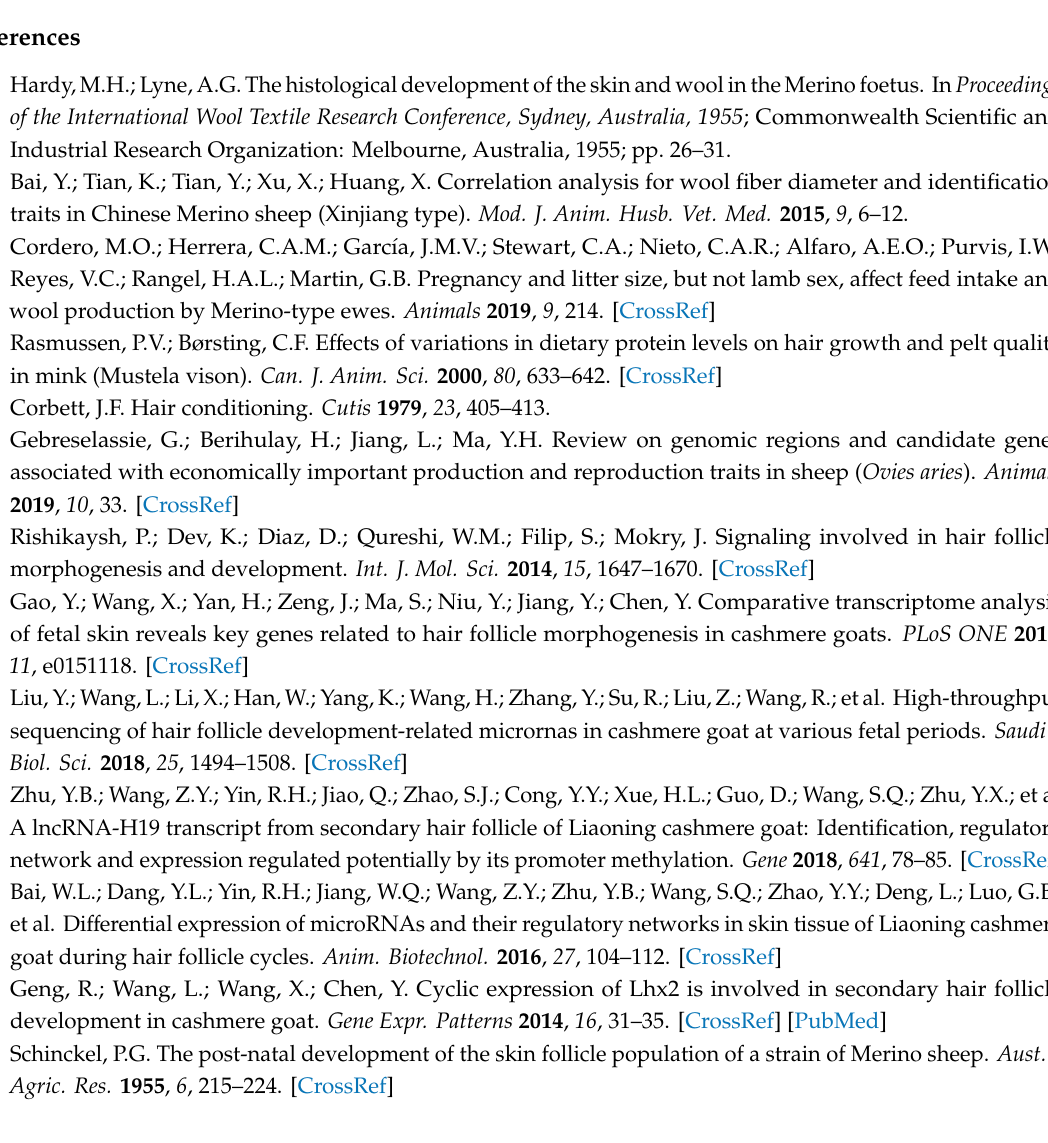
Table S1: Energy standard and daily feeding intake of experimental ewe in maintenance group. Table S2: Changes of blood biochemical indexes in the M and sub-M group ewes. Table S3: Primer information of qRT-PCR. Table S4: Comparison of fetal body size of the M and Sub-M fetuses at di ff erent stages of gestation. Table S5: List of DEGs in D135 vs. D105. Table S6: List of DEGs in DR135 vs. D105. Table S7: List of DEGs in DR135 vs. D135. Figure S1: qRT-PCR validation of the 8